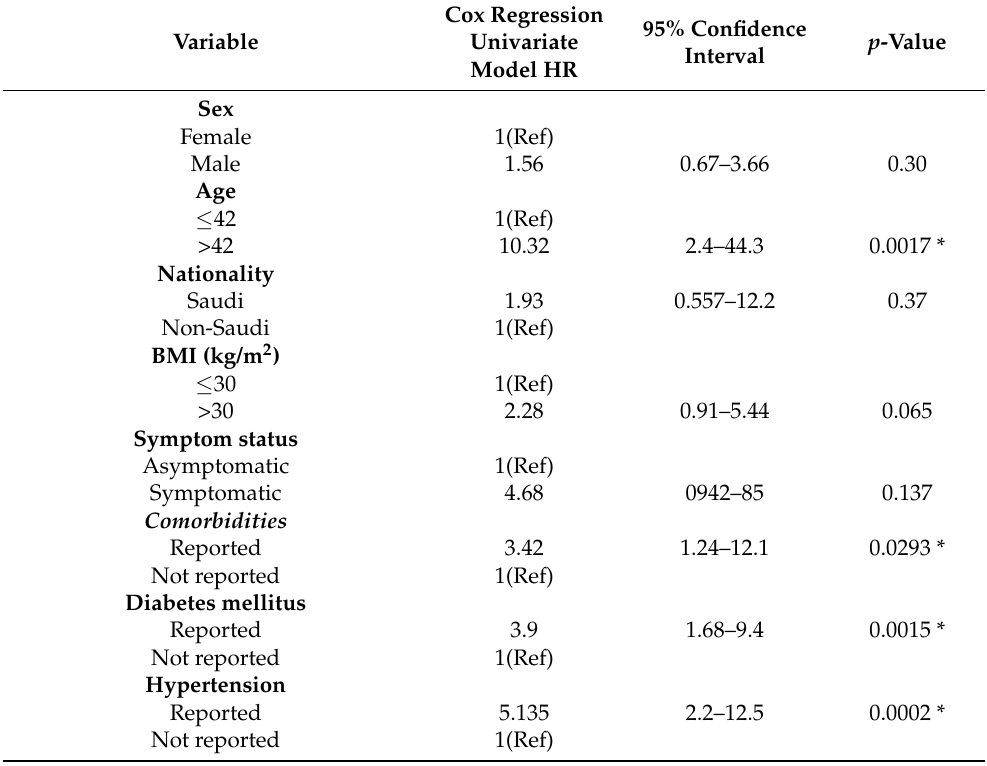
Table 5. Association of demographic and clinical characteristics and treatment regimen with death in patients with confirmed